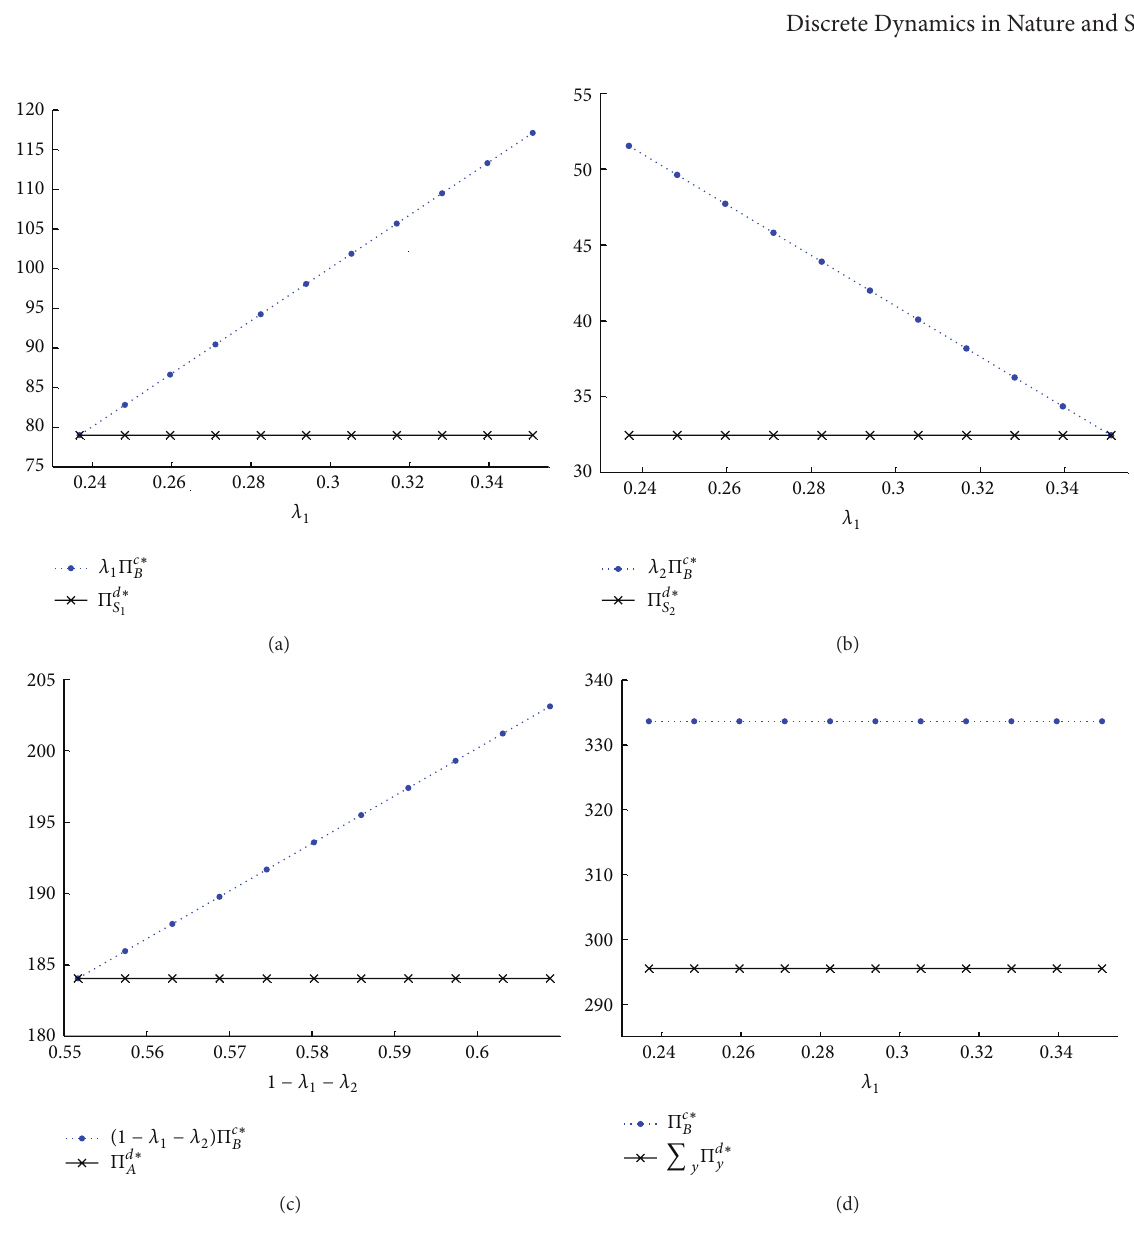
Figure 1: Effectiveness of the advance payment contract under different 𝜆 𝑖